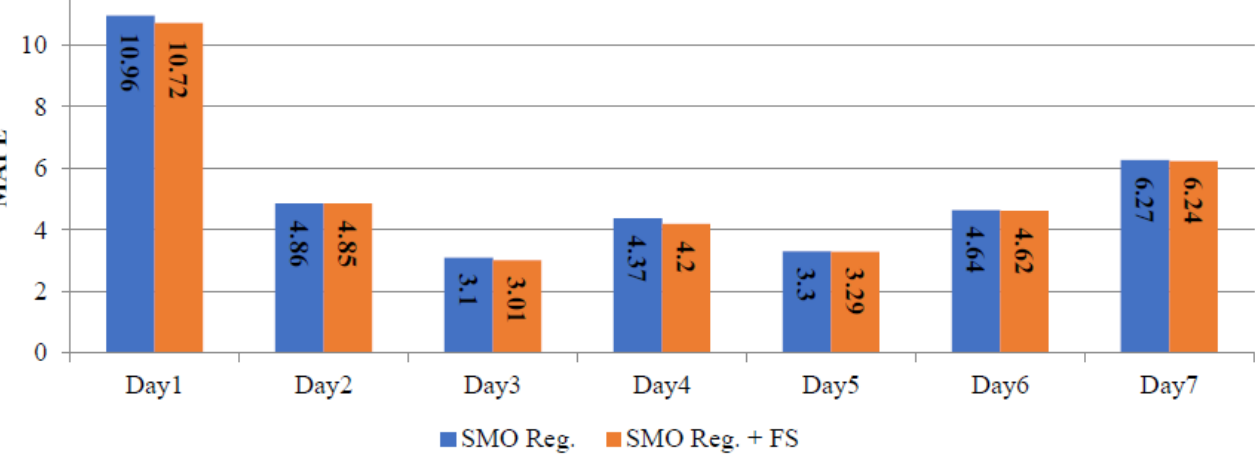
Figure 8. Daily MAPE corresponding to SMO reg. and SMO reg.+ FS for summer season.